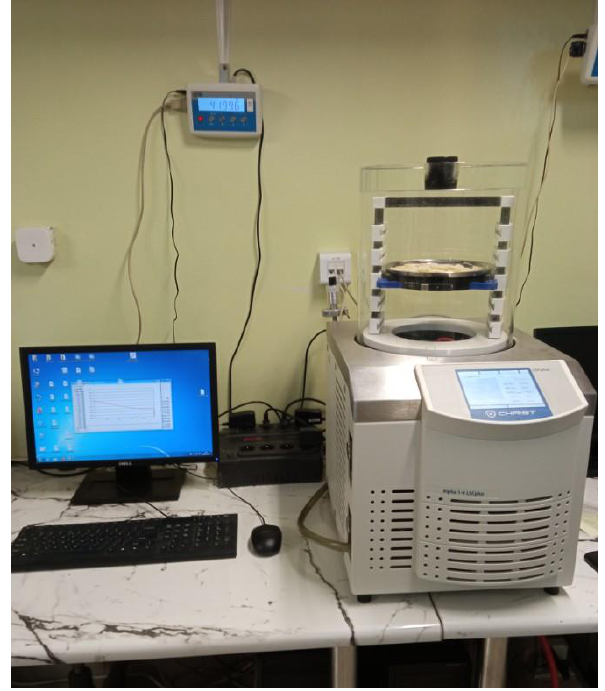
Figure 2. Measuring stand for the recording of mass changes of sample during FD.